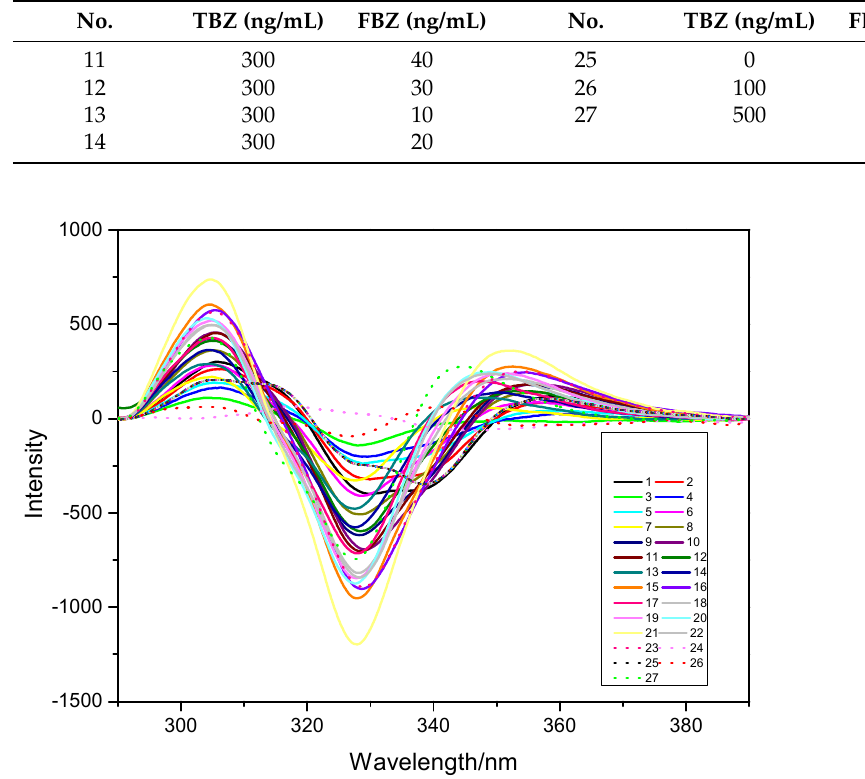
Figure 7. Second derivative constant-energy synchronous fluorescence spectra with 27 calibration sets.